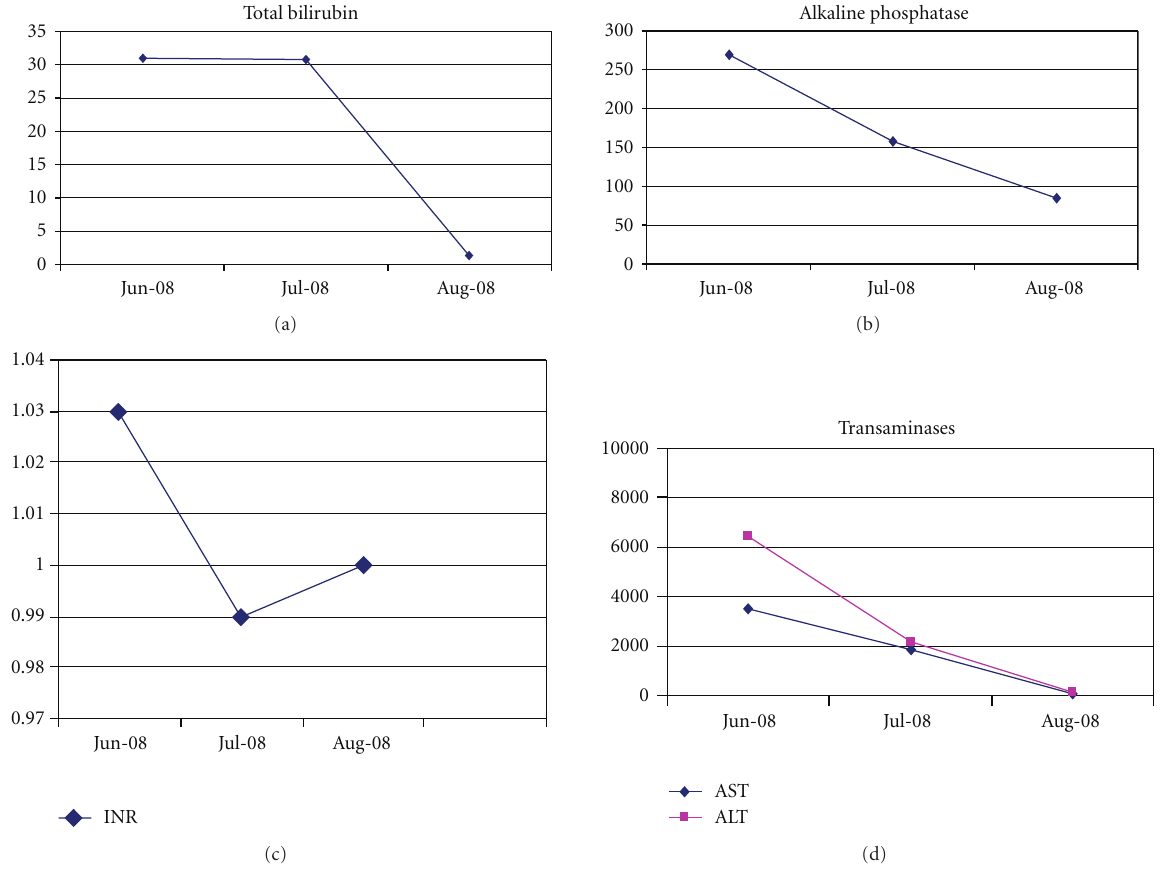
Figure 2: Followup labs at 6